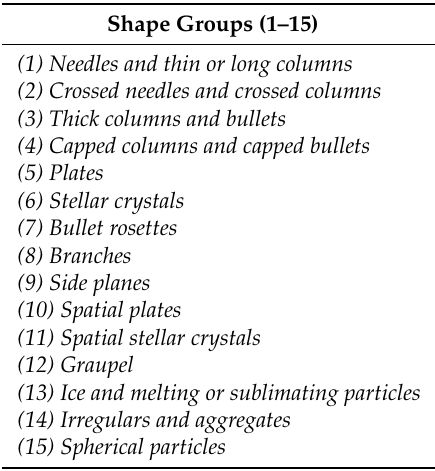
Table 3. Shape groups